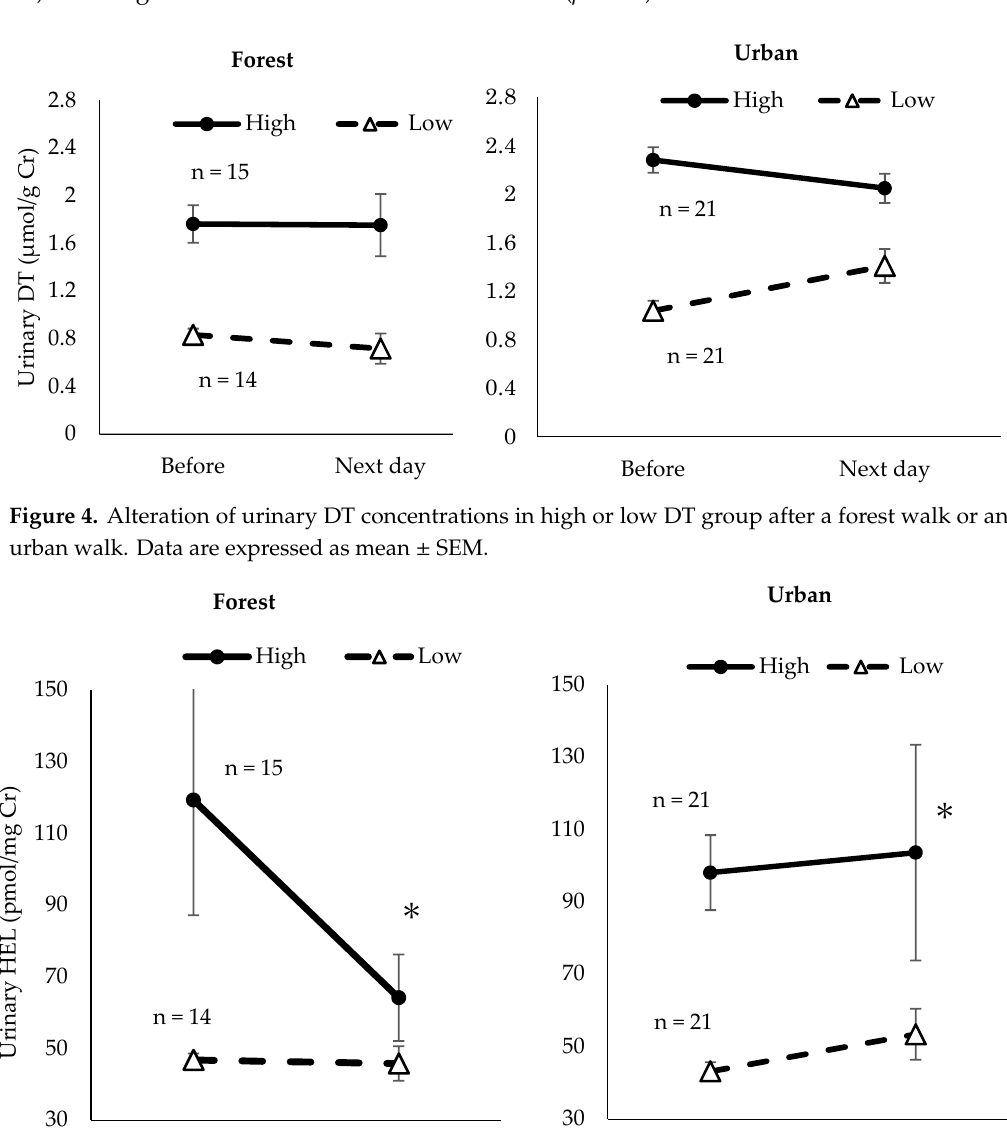
Figure 3. Urinary hexanoyl-lysine (HEL) concentration pre- and post-forest walk or urban walk. “ ― ” denotes mean;